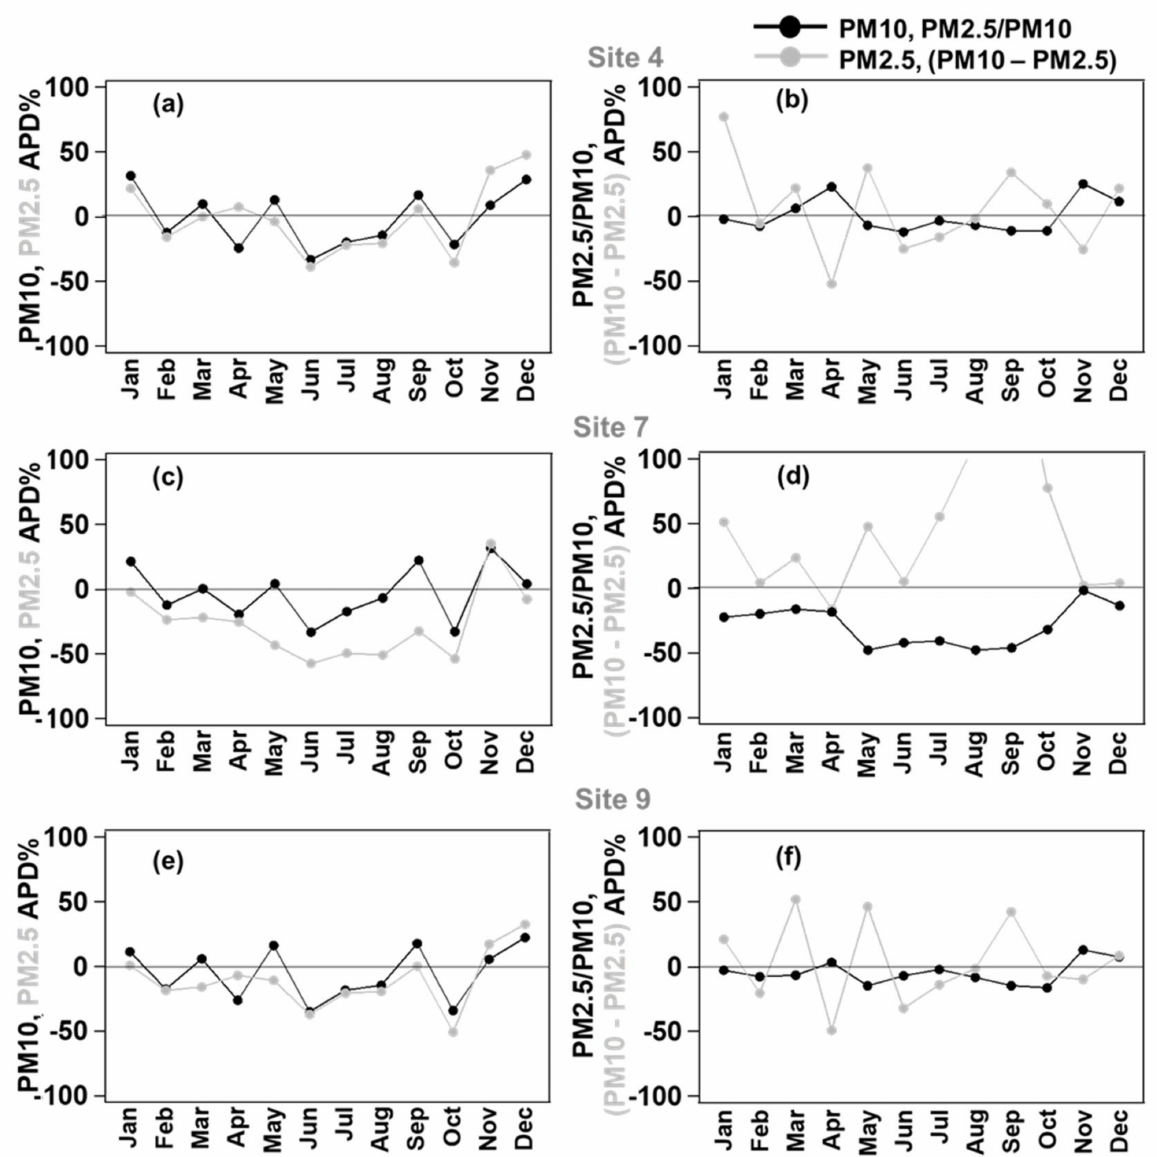
Figure 6. Monthly evolution of Average Percent Departure (APD%) of PM10 (black) and PM2.5 (grey) mass concentration and of PM2.5/PM10 mass ratio (black) and (PM10–PM2.5) coarse fraction concentration (grey) for Site 4 (Lecce—Libertini; ( a , b ), respectively), for Site 7 (Campi Salentina; ( c , d ), respectively), and for Site 9 (Cerrate; ( e , f ),